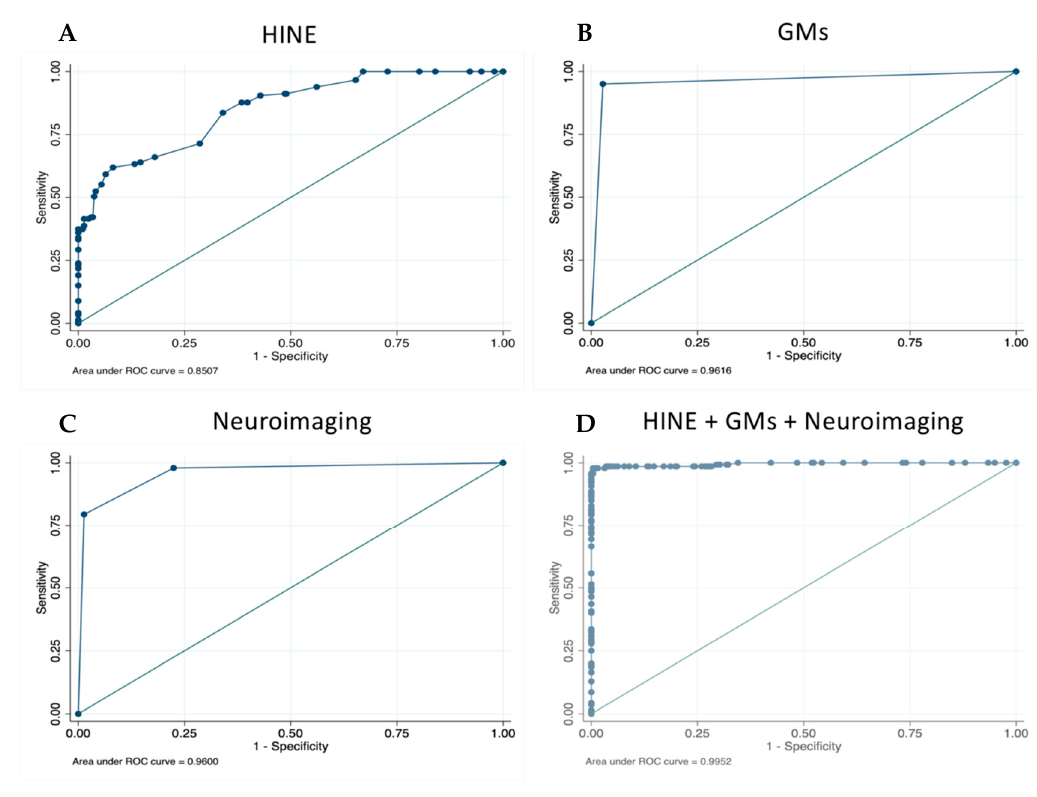
Figure 2. ( A ) Logistic regression of HINE at 3 months; ( B ) GMs, absent fidgety vs normal fidgety (abnormal removed); ( C ) neuroimaging, predict CP vs. predict no CP; ( D ) HINE + GMs (fidgety) + neuroimaging.